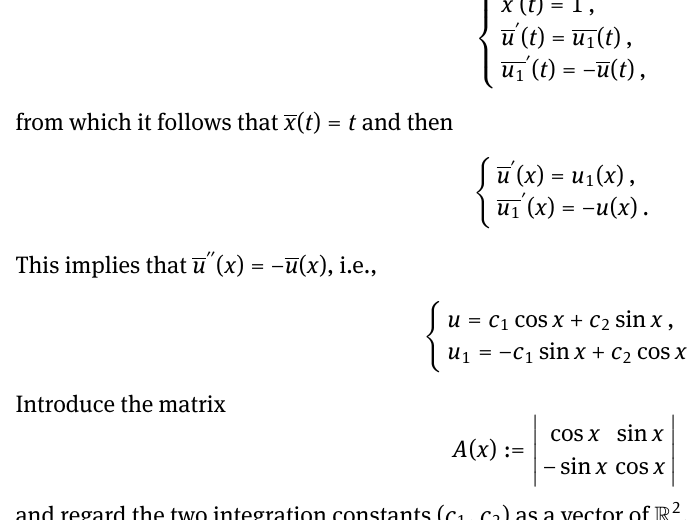
In other words, the vector field Z := ∂ x + u 1 ∂ u − u∂ u plane, two vector fields, namely D and V , are necessary to span C F